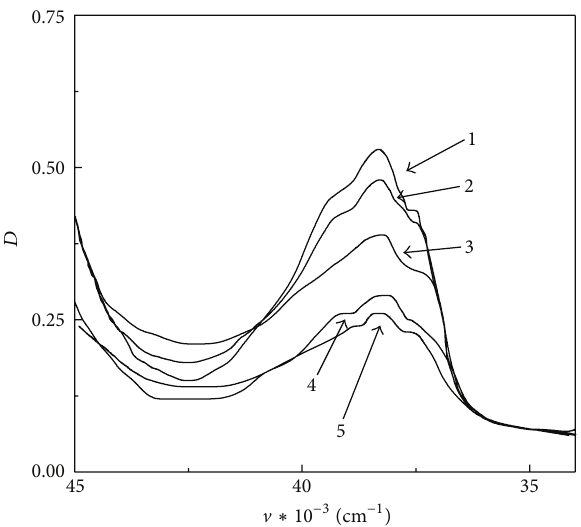
Figure 4: An effect of the photocatalyst (TiO 2 ) on the photolysis kinetics of CPB: 1—spectrum of the feed solution; 2—the same after irradiating by UV light in the absence of TiO 2 ; 3—the same by using the nonmodified TiO 2 ; 4 and 5—the TiO 2 samples alloyed by correspondingly iron and platinum.